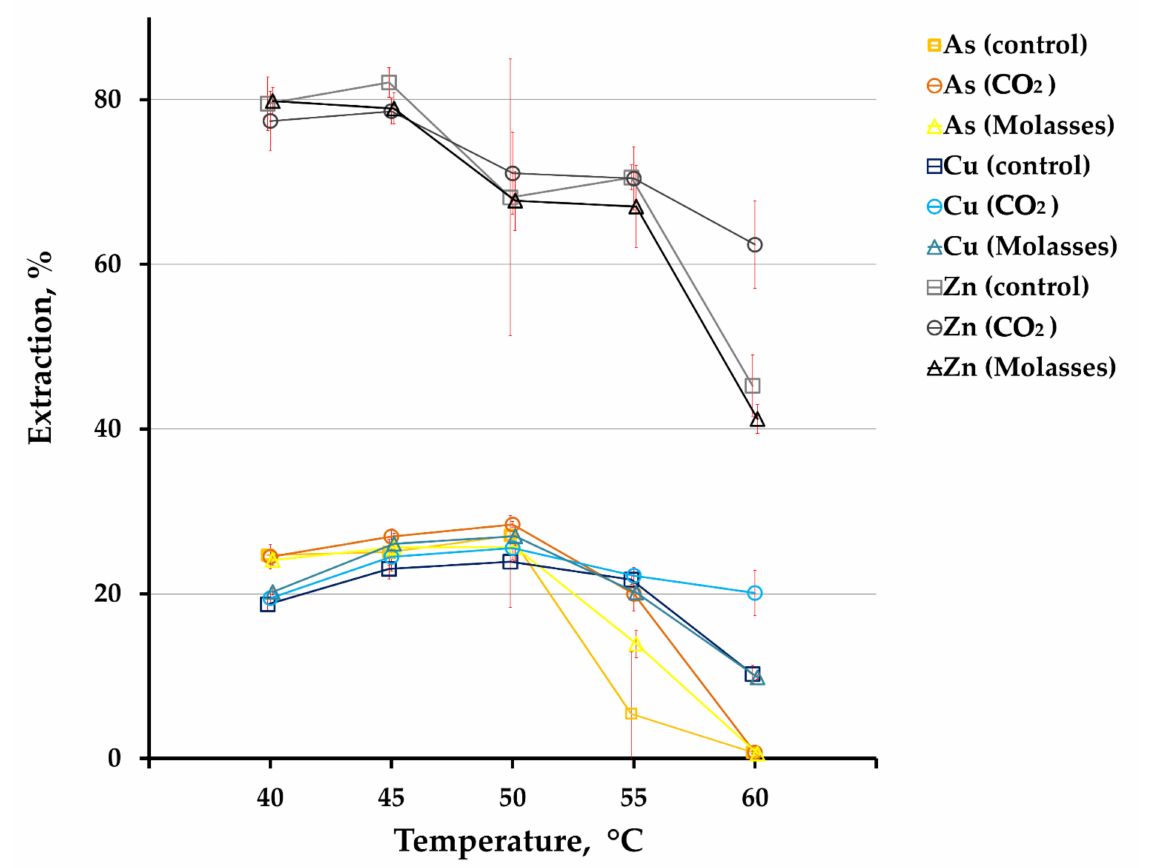
Figure 1. As, Cu, and Zn extraction (%) during